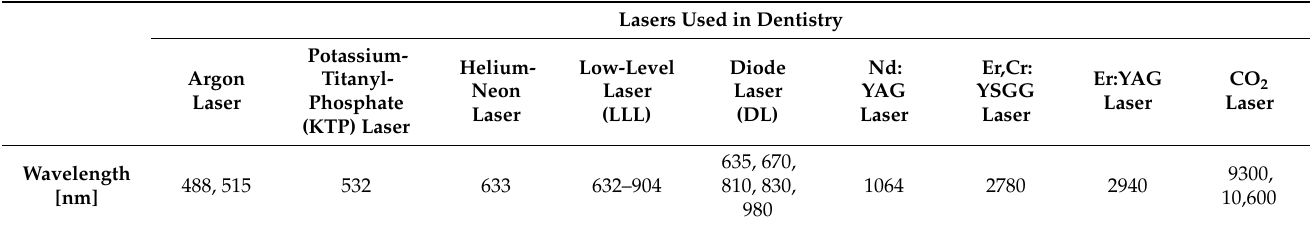
Table 1. Types of lasers used in dental medicine and their